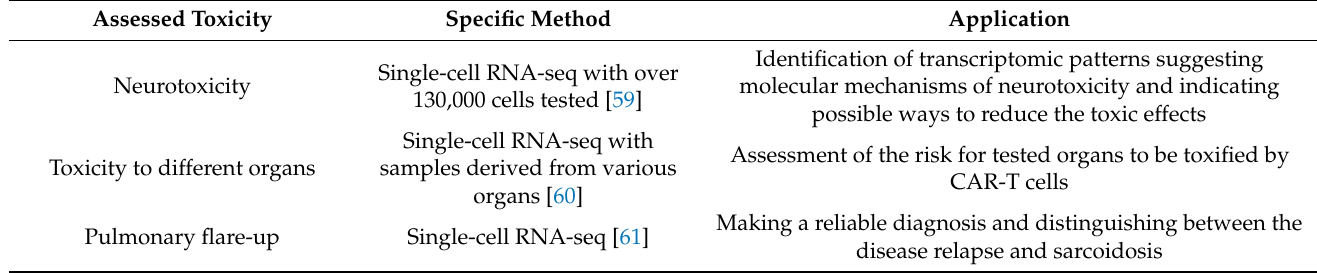
Table 4. Transcriptomics as a method for assessment of toxicity of CAR-T